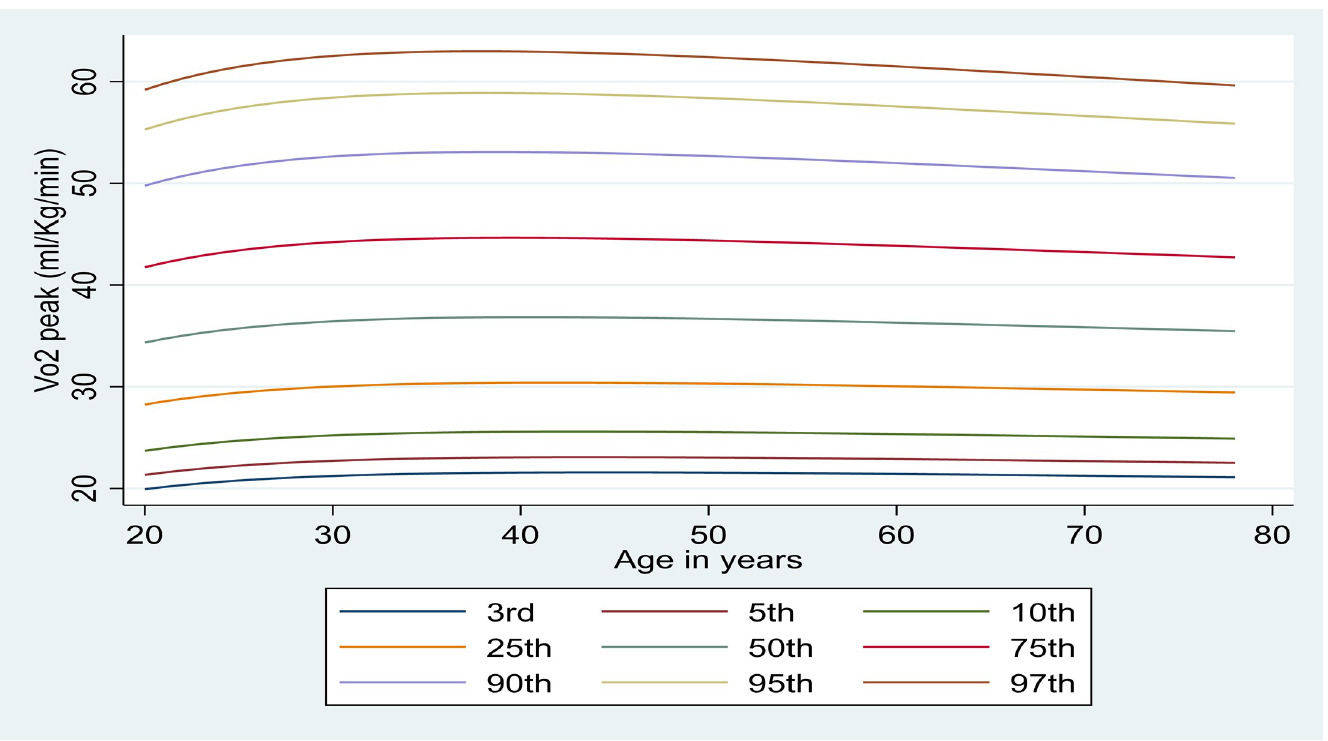
Fig 2. Peak VO 2 (ml � kg -1 � min -1 ) centile reference curves in apparently healthy British females.